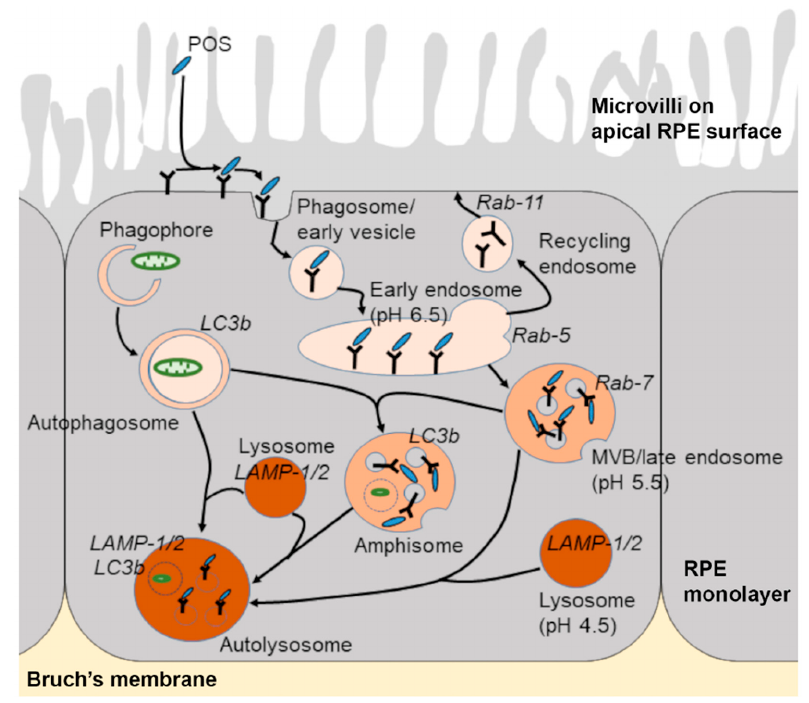
Figure 2. Schematic diagram showing the endo-lysosomal and autophagy pathways. Shed photoreceptor outer segment (POS) disks bind to the apical RPE surface following light onset and are internalised via a series of phagocytic and endosomal compartments prior to converging with